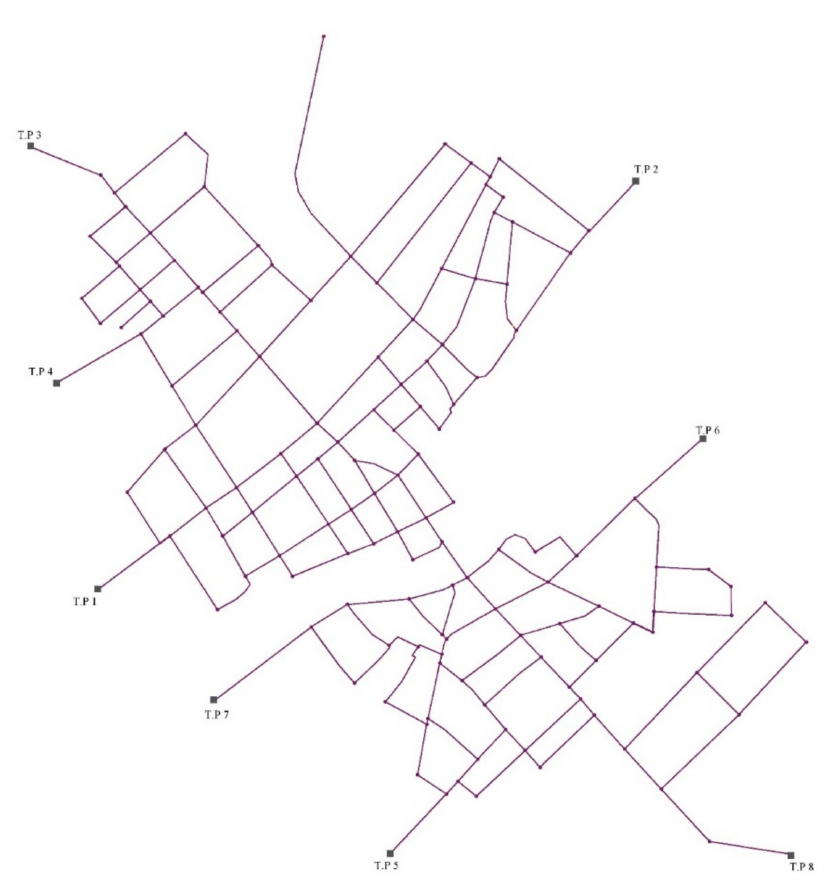
Figure 8. The base graph of the case